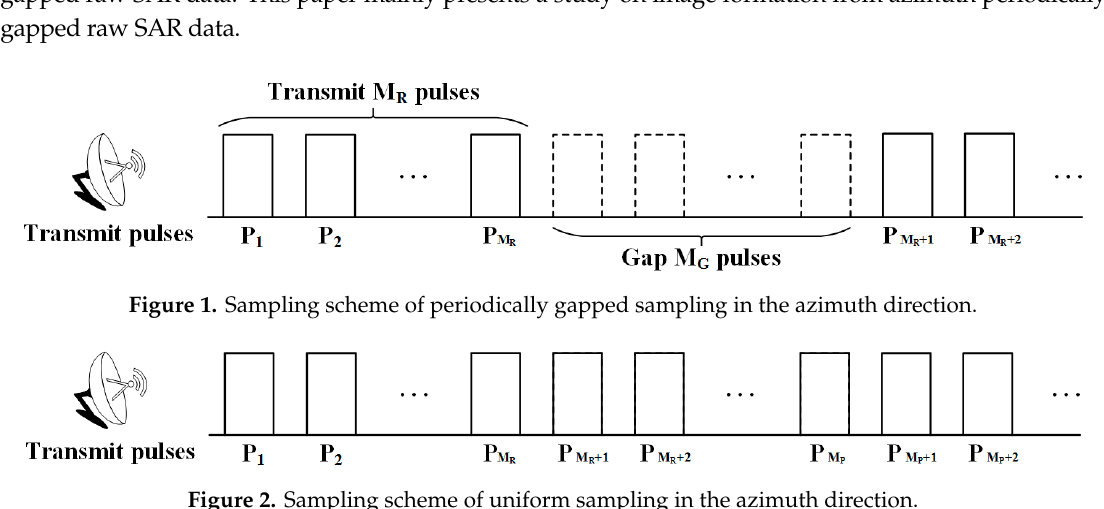
Figure 2. Sampling scheme of uniform sampling in the azimuth direction.